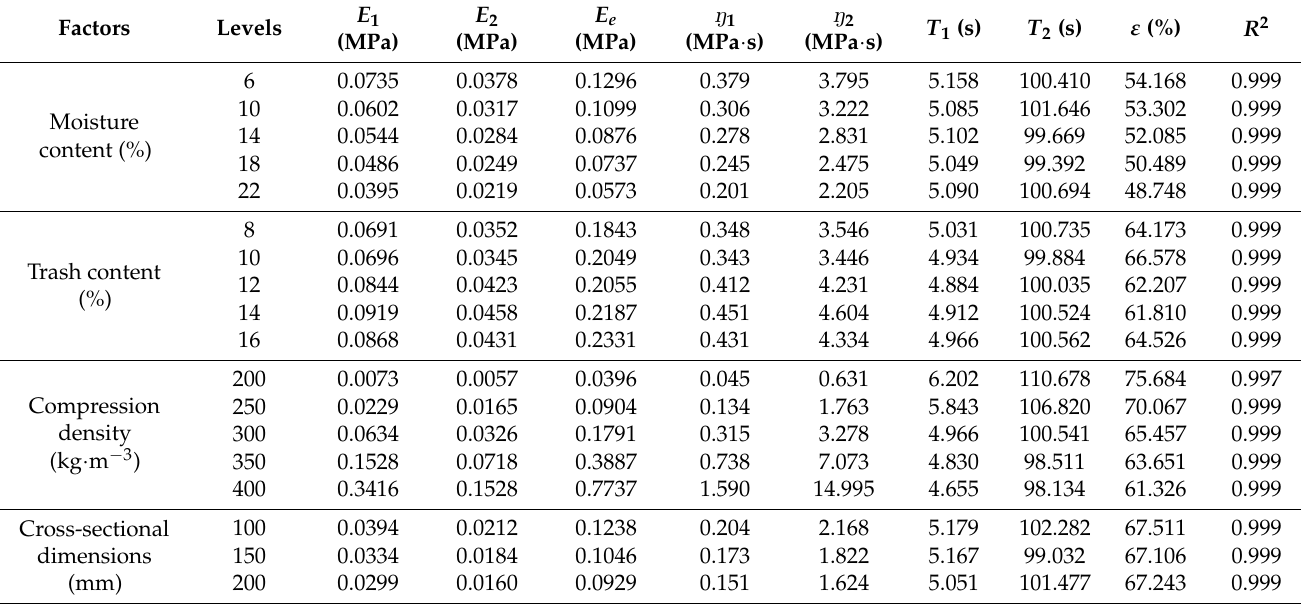
Table 2. Parameters of stress relaxation of machine-harvested